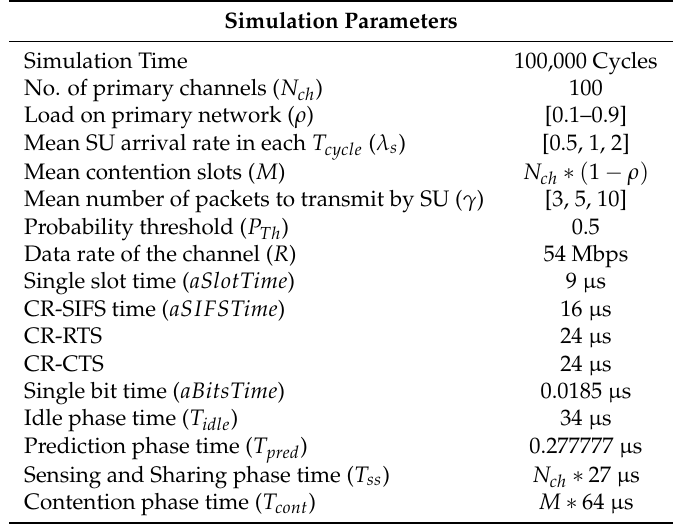
Figure 4. Flow diagram of the proposed model. Table 3. Simulation